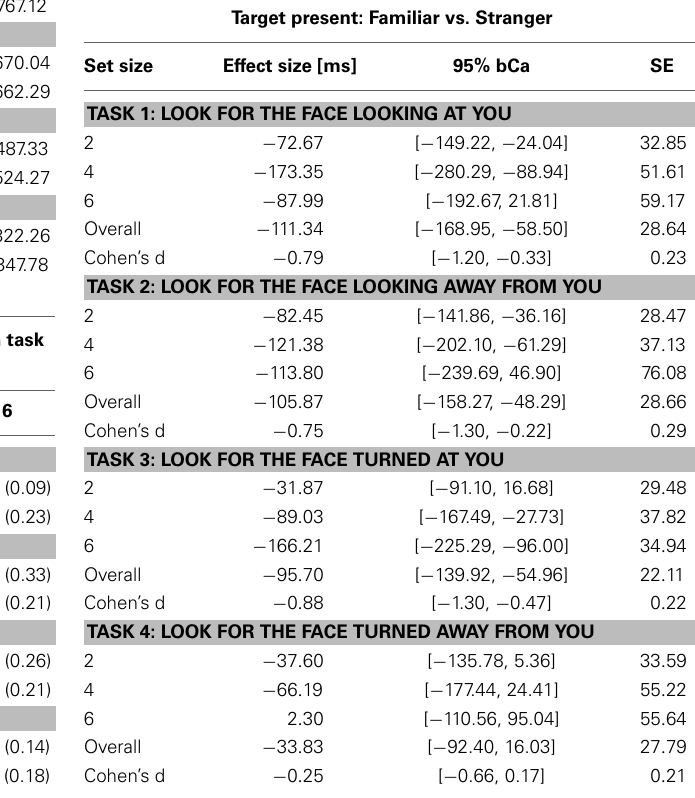
Table 3 | Unstandardized effect size [ms] of familiarity for the Target Present condition and Cohen’s d effect size of familiarity across set sizes in the four tasks (bCa bias-corrected and accelerated confidence intervals, computed with 10,000